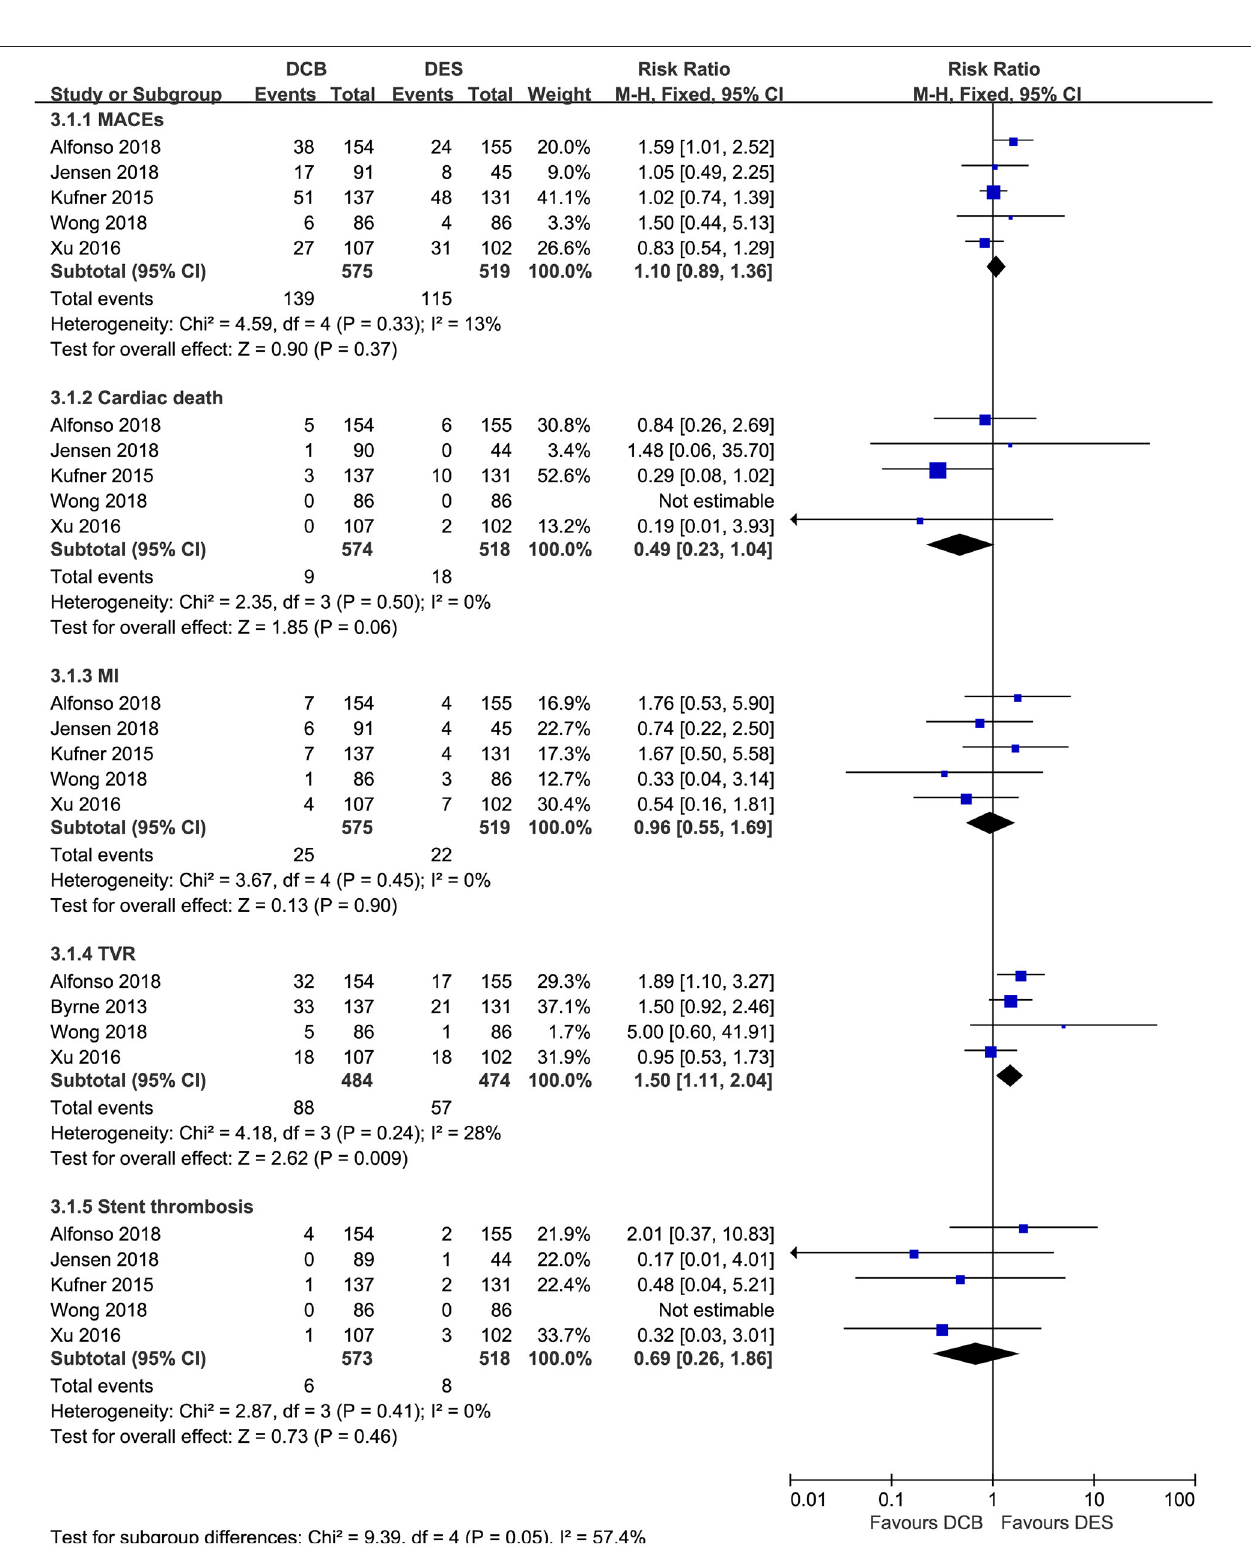
FIGURE 5 | Forest plot comparing secondary outcomes between repeat DES implantation and DCB angioplasty. DES, drug-eluting stents; DCB, drug-coated balloon; MACEs, major adverse cardiac events; MI, myocardial infarction; TVR, target vessel revascularization.